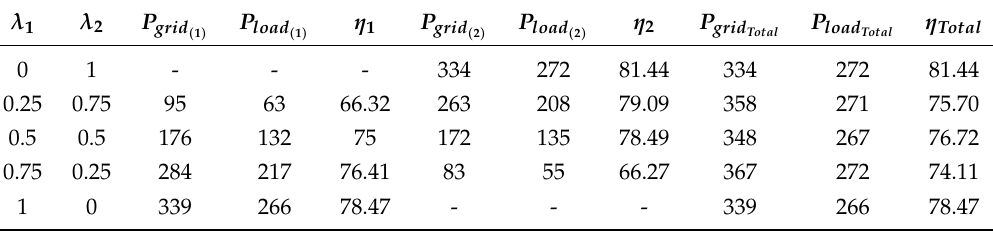
Table 5. Powers (W) and efficiencies (%) when the non-linear load is